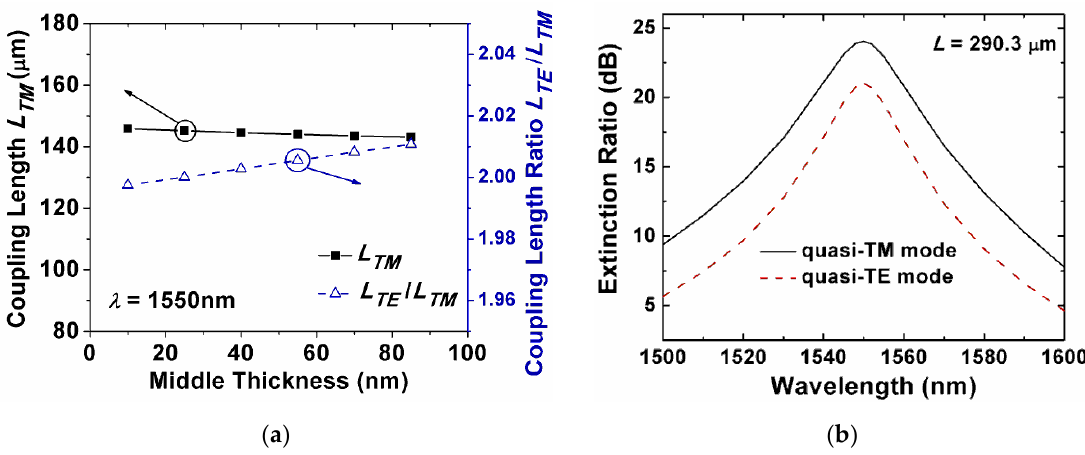
Figure 11. ( a ) Coupling length of the quasi-TM mode and the coupling length ratio as a function of the middle Si 3 N 4 layer thickness H m between the two SiO 2 slots; and ( b ) the extinction ratio of the quasi-TM mode at the bar port and the quasi-TE mode at the cross port for the multi-slot-waveguide-based PBS.